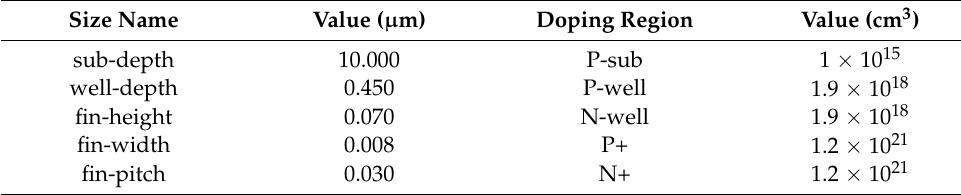
Table 2. The intrinsic parameters in FinFET process used in simulation.